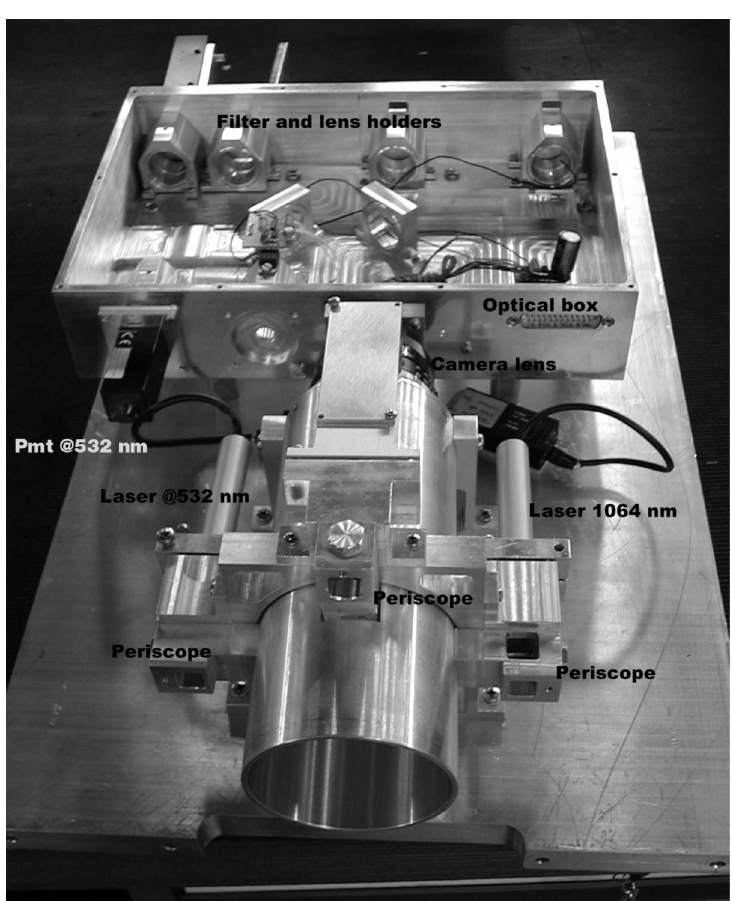
Fig. 1. MAS at the end of mechanical buildup. From above note the optical box with the supports for all the optics, the telescope with the two lasers on its side and the